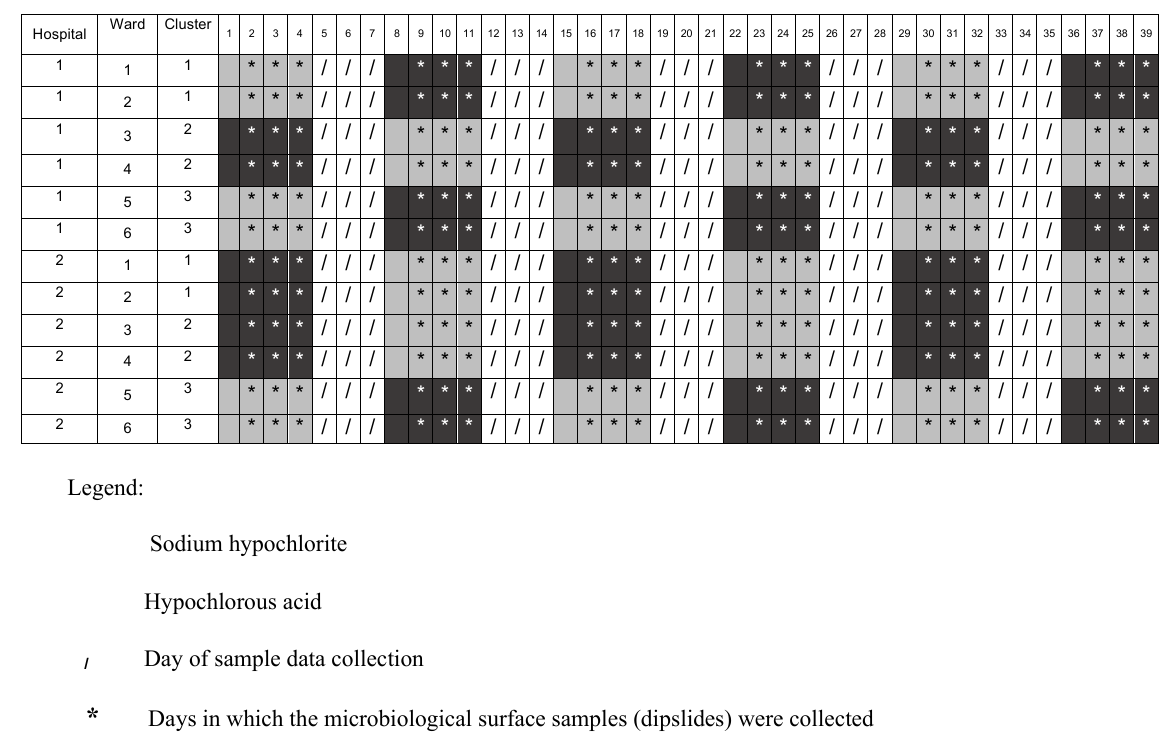
Figure 1. Intervention structure over a six-week